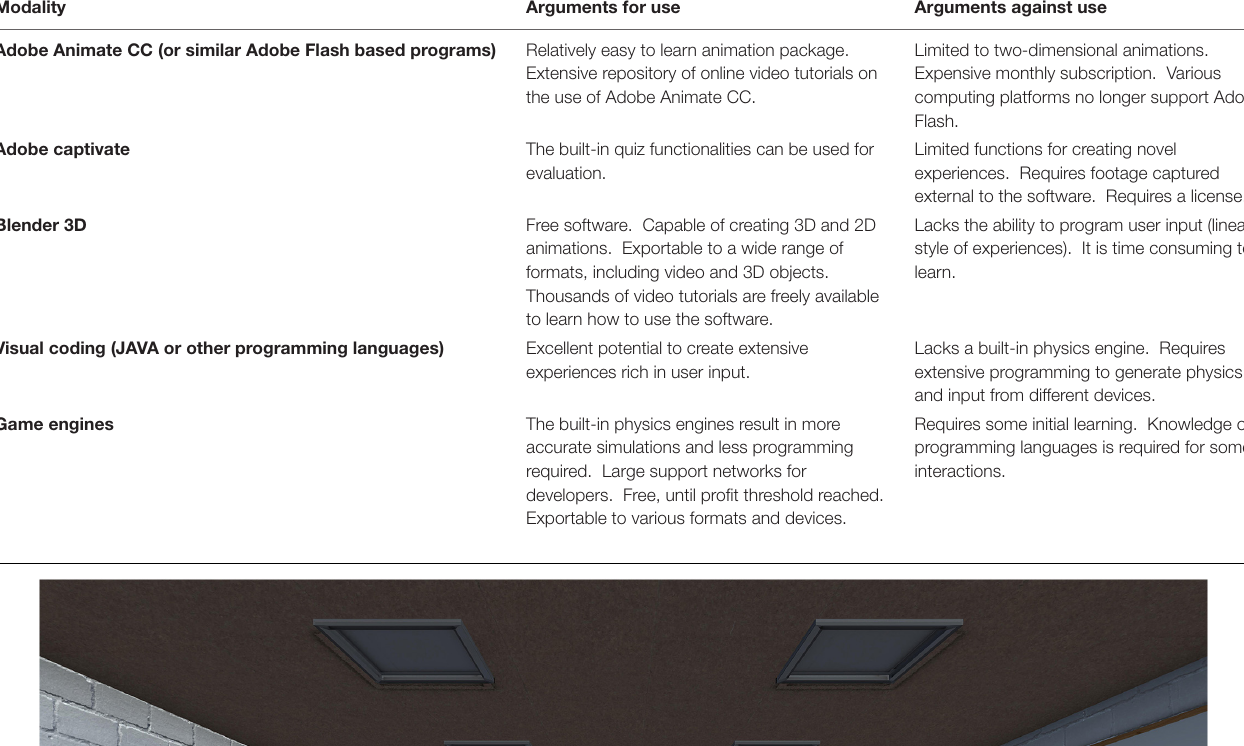
TABLE 1 | Pros and cons list of potential software applications that could be used to create VLs. Modality Arguments for use Arguments against use